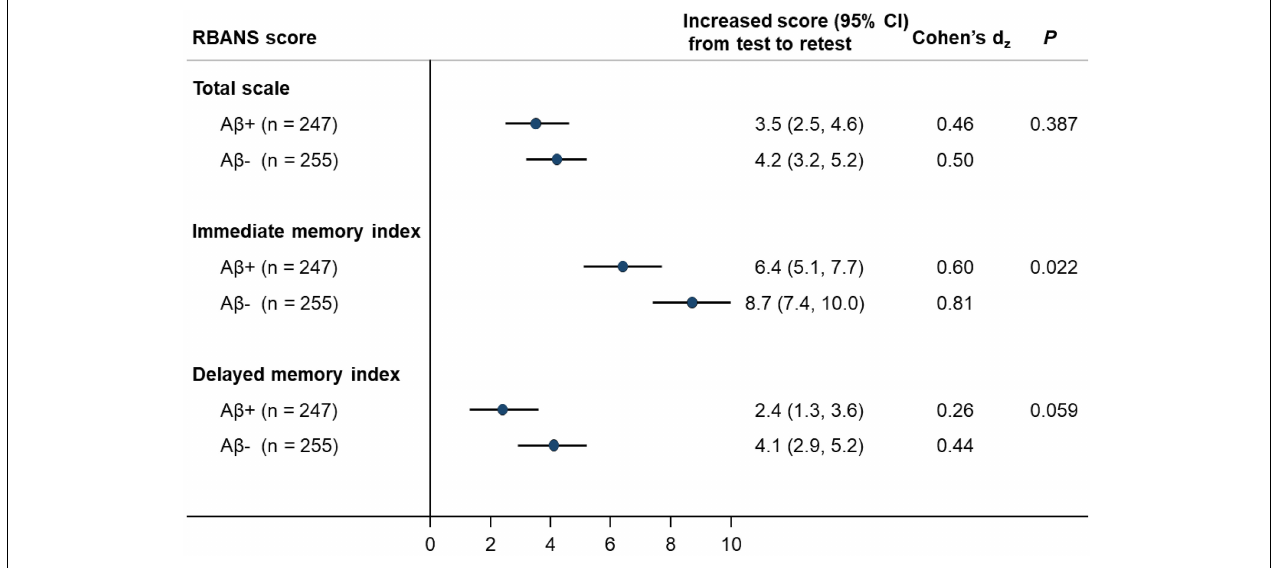
FIGURE 1 | Associations between amyloid status with magnitude of RBANS practice effects ( N = 502). RBANS, Repeatable Battery for the Assessment of Neuropsychological Status; CI, confidence interval. Estimates were adjusted for age, sex, education level, APOE - ε 4 carriage and initial RBANS level, where